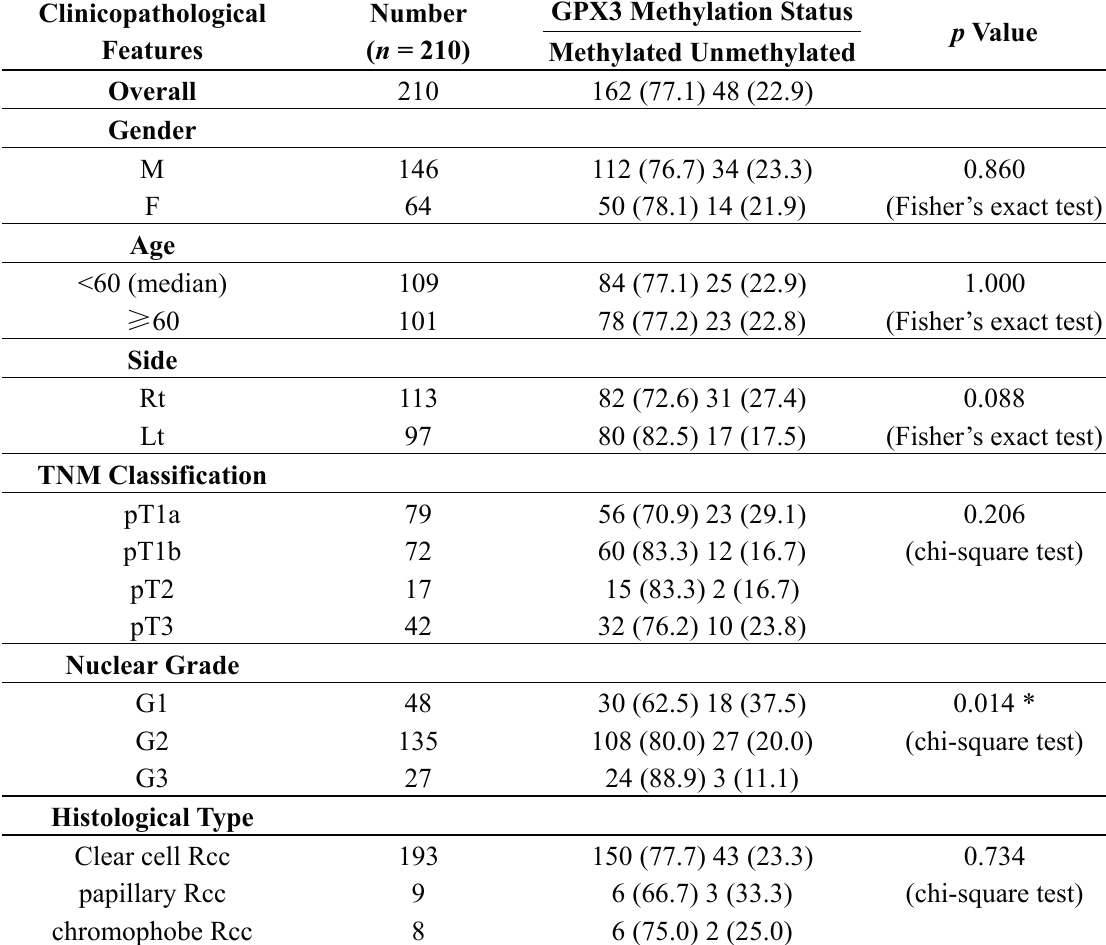
Figure 4. ( A ) Representative MSP results of GPX3 methylation in RCC primary tumors (T) and paired adjacent non-tumor tissues (N). M , methylated; U , unmethylated; ( B ) Representative bisulfite genomic sequencing results of cloned BGS-PCR products. Methylated CpG sites will appear as CG during sequencing, while unmethylated CpG sites as TG. Table 1. Association between GPX3 methylation and clinicopathological features of patients with